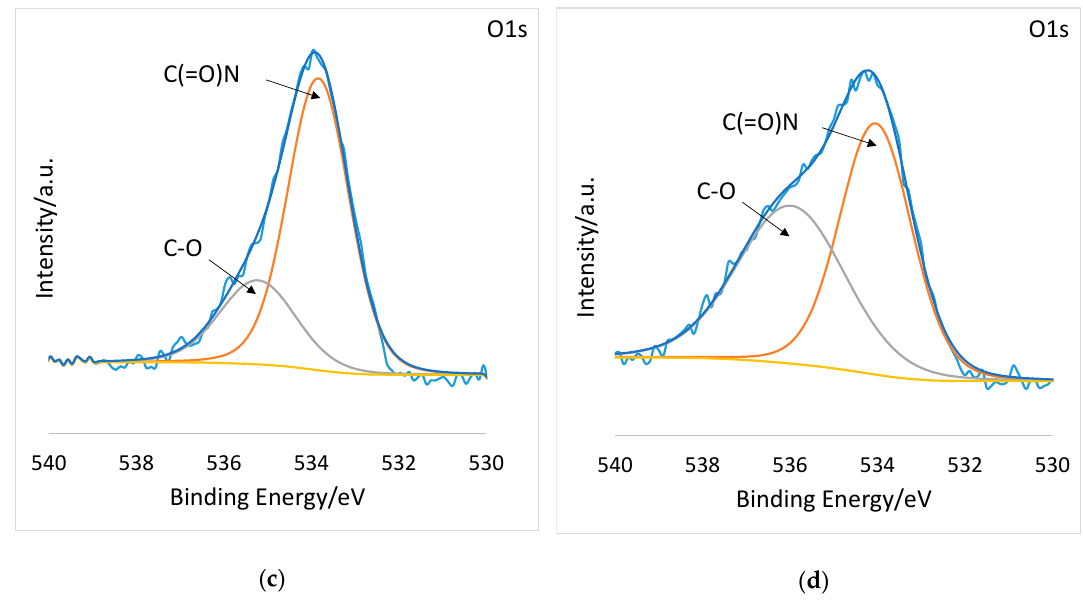
Figure 4. High resolution C1s and O1s spectra of PSI-AAm ( a , c ) and PSI-AAmp ( b , d ). Table 2. High-resolution C1s and O1s XPS spectra of PSI-AAm and Table 1. XPS survey spectra of PSI-AAm and PSI-AAmp.